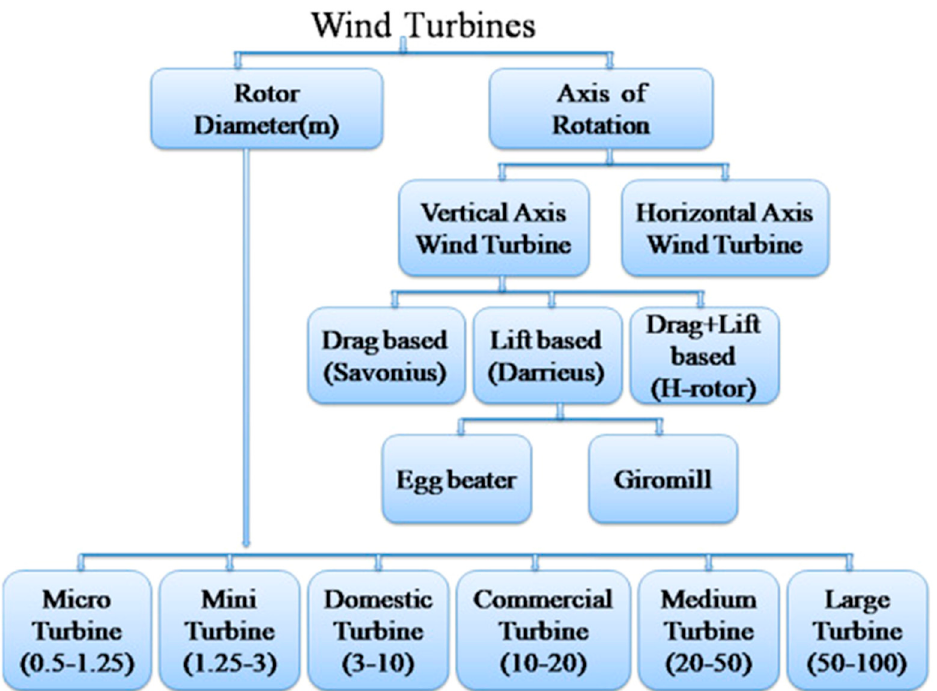
Figure 8. Classification of wind turbines (Reprinted with permission from Ref. [80]. 2020, Elsevier)